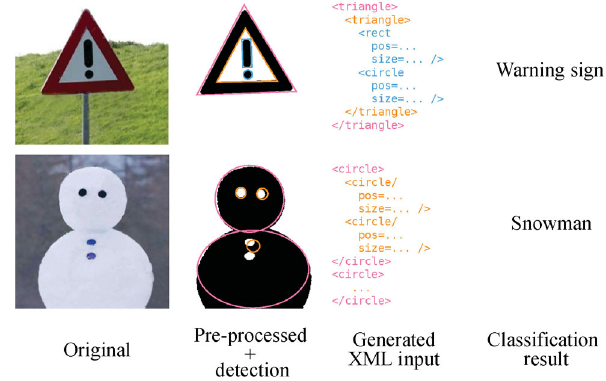
Fig. 9 Recognition-by-components demonstration using our proposed hierarchical primitive detection